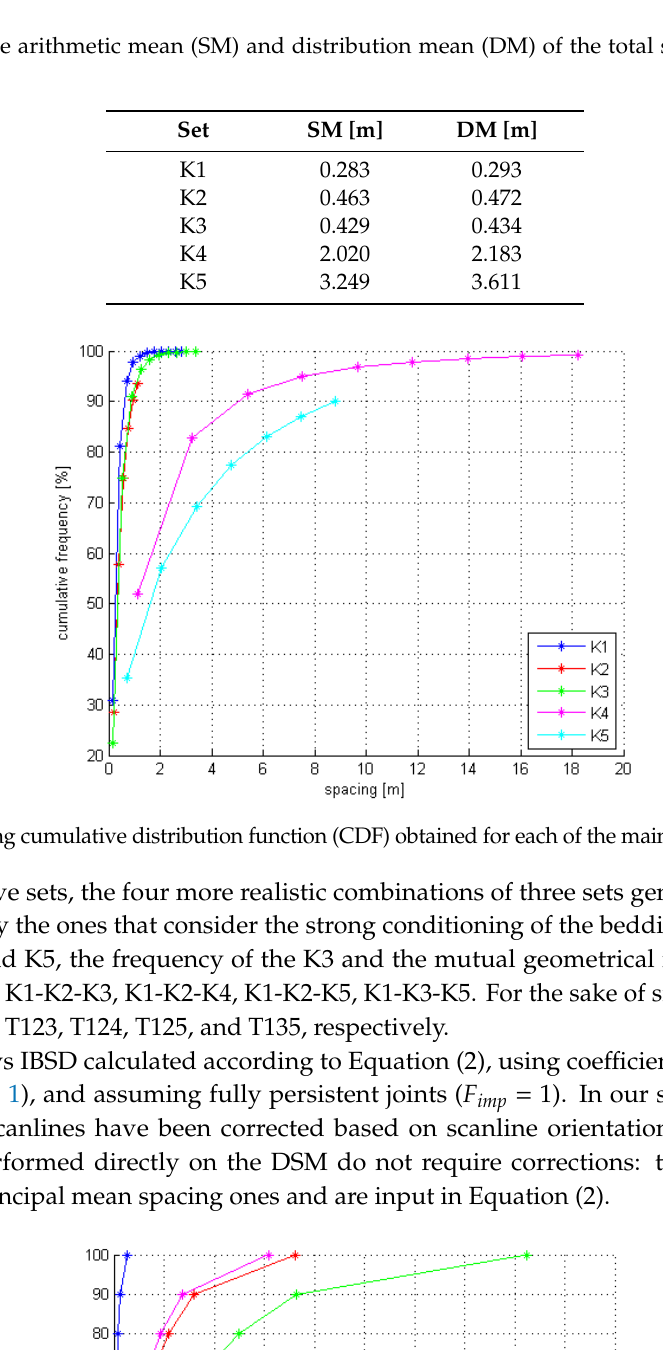
Table 6. Sample arithmetic mean (SM) and distribution mean (DM) of the total spacing sample of each set.